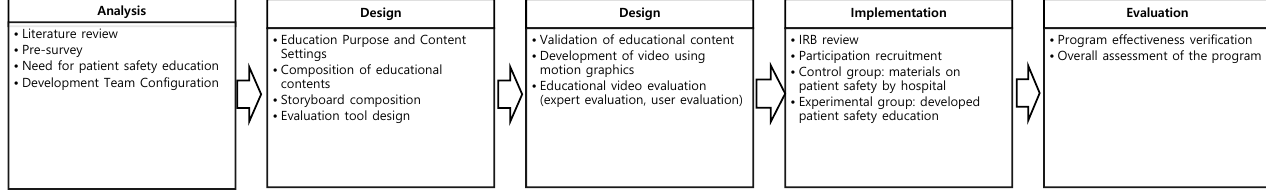
Figure 1. ADDIE application for program development in this study Figure 1. Analysis–design–development–implementation–evaluation (ADDIE) application for program development in this